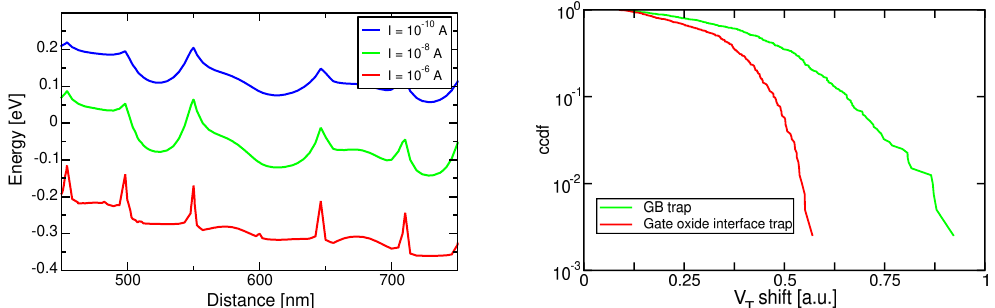
Figure 3. ( Left ) Conduction band profile for a 3D NAND string at different current levels. ( right ) RTN complementary cumulative distribution functions (ccdfs) for traps placed at the GBs or at the gate/oxide interface for a template